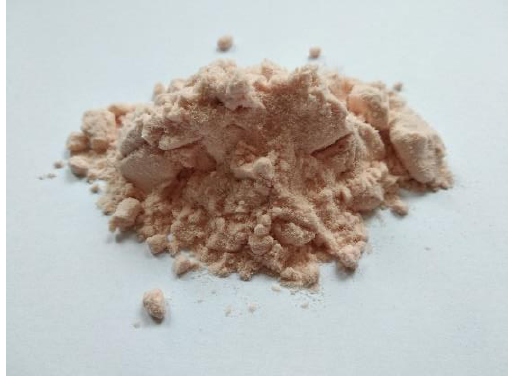
Figure 2. LF isolated from milk [phot. A. Jańczuk].